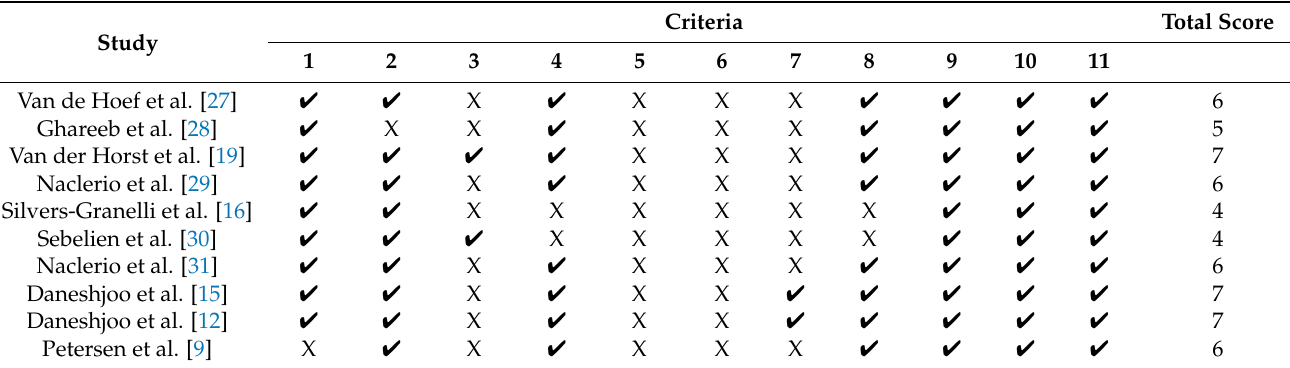
Table 2. Completed PEDro quality